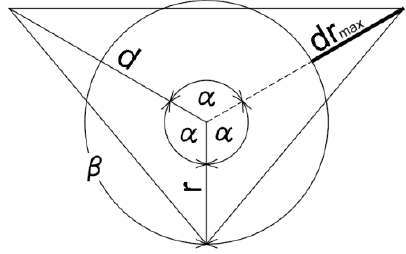
Figure 5. Maximum dr values for α = 120°, when β = 360 o , n = 3.